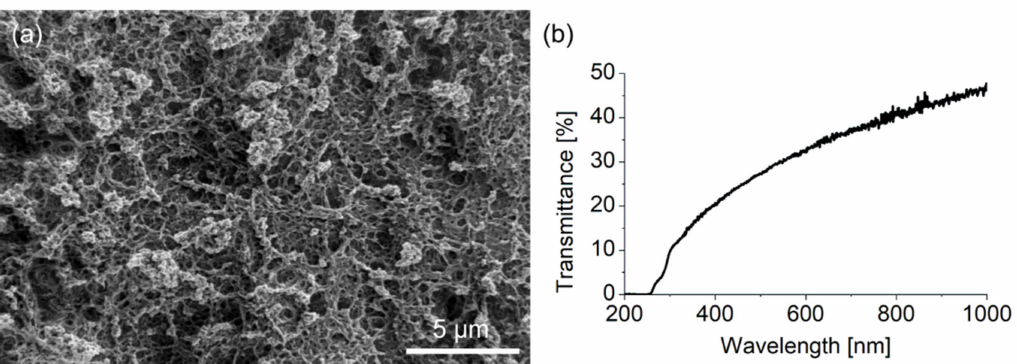
Figure A2. Analysis of structure and transmission of Fluoropor films: ( a ) Micro-graphical image of a Fluoropor film used on the DMF device for droplet actuation showing the micro/nanoporous structure of Fluoropor. ( b ) UV-VIS transmission spectra of a 51 µ m thick Fluoropor film showing moderate transparency for visible light.